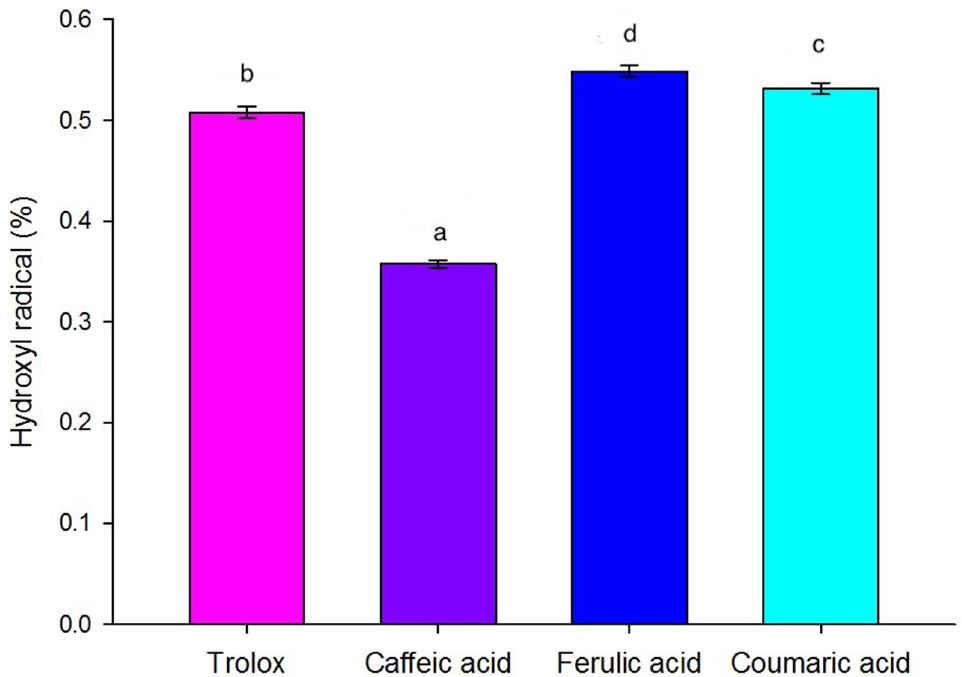
Figure 4. Percentage of hydroxyl radical of pericarp comparison with Trolox, caffeic acid, ferulic acid, coumaric acid (0.1 M). Values reported as percentage (%). Values presented are the average of three replicates ± standard deviation. Different letters indicate that the values are significantly different ( p < 0.05).